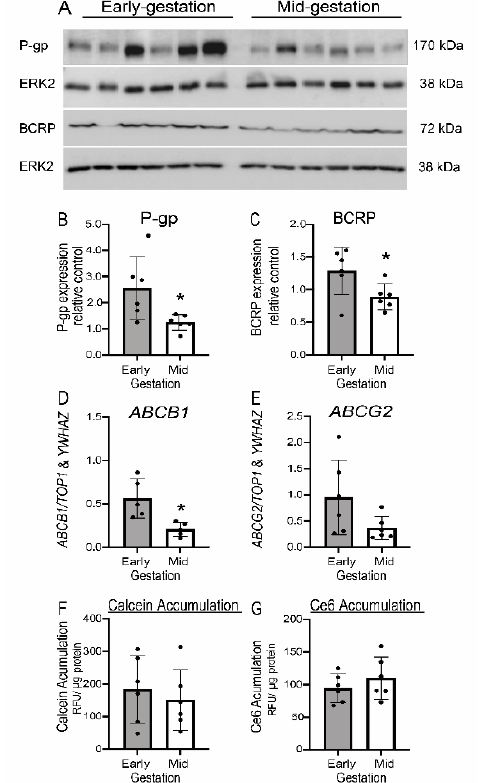
Figure 7. Developmental expression and function of P-glycoprotein (P-gp/ ABCB1 ) and breast cancer resistance protein (BCRP/ ABCG2 ) in early and mid-gestation primary human fetal brain endothelial cells (hfBECs). ( A ) Representative images of western blots ( B ) densitometric analysis of total P-gp and ( C ) BCRP protein comparing early and mid-gestation hfBECs. ERK2 is used as loading control. ( D ) Relative ABCB1 (encoding P-gp) and ( E ) ABCG2 (encoding BCRP) mRNA expression in early and mid-gestation hfBECs. Data are normalized by the geometric mean of TOP1 and YWHAZ (reference genes), ( F ) calcein-AM (P-gp substrate) and ( G ) Ce6 (BCRP substrate) accumulation in early and mid-gestation hfBECs. Data are expressed as mean ± SD. n = 6/gp. Statistical differences were conducted using an unpaired t -test. * p ≤ 0.05.